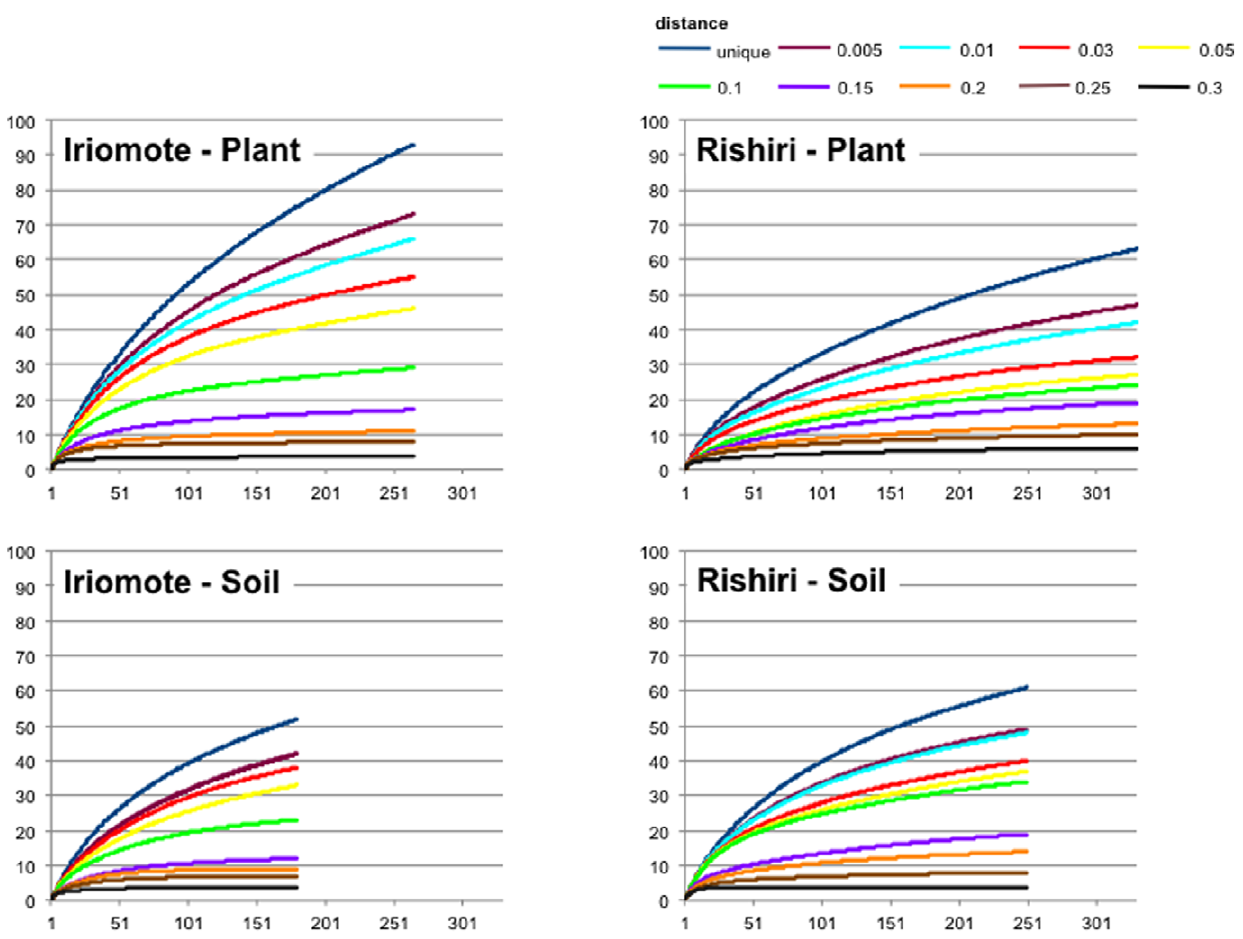
Figure 2. Comparison of rarefaction curves among plant and soil samples of Iriomote and Rishiri Islands. Rarefaction values were obtained using the MOTHUR program [25] and data of some particular thresholds of a respective group are plotted. Numerals in the boxes indicate the value of chao (chao_lci – chao_hci) of distances unique, 0.005, 0.03 and 0.01 from the top in the respective group.